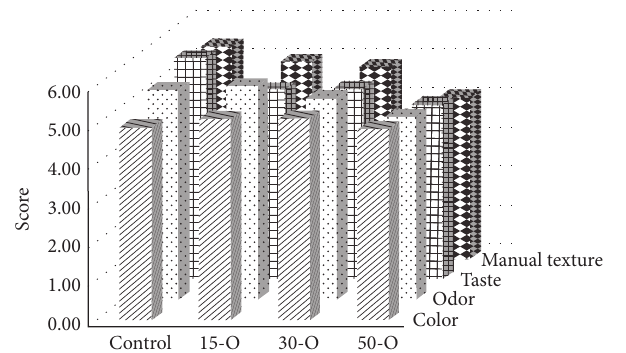
Figure 2: Sensory assessment.